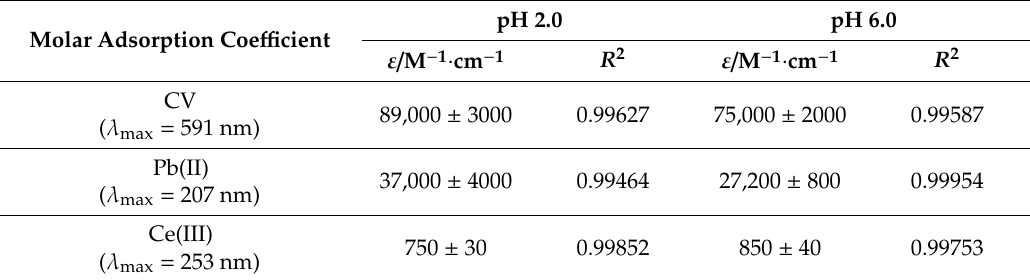
Table 1. Molar adsorption coe ffi cient values ( ε / M − 1 · cm − 1 ) of crystal violet dye (CV), Pb(II) and Ce(III) at pH 2.0 and